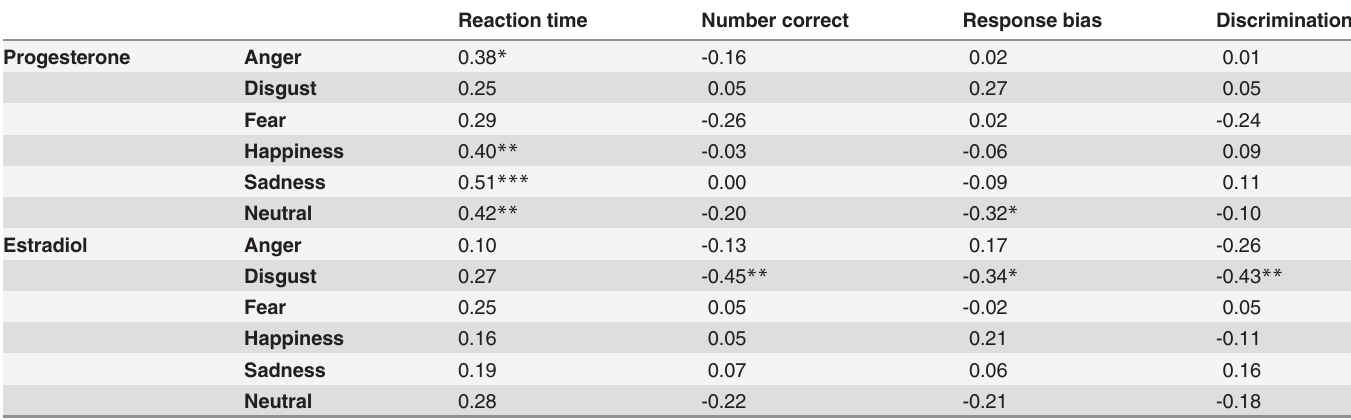
Table 2. Pearson ’ s correlation coefficients expressing the relationship between progesterone 1 and estradiol and indices of emotion recognition performance for six facial expressions. Reaction